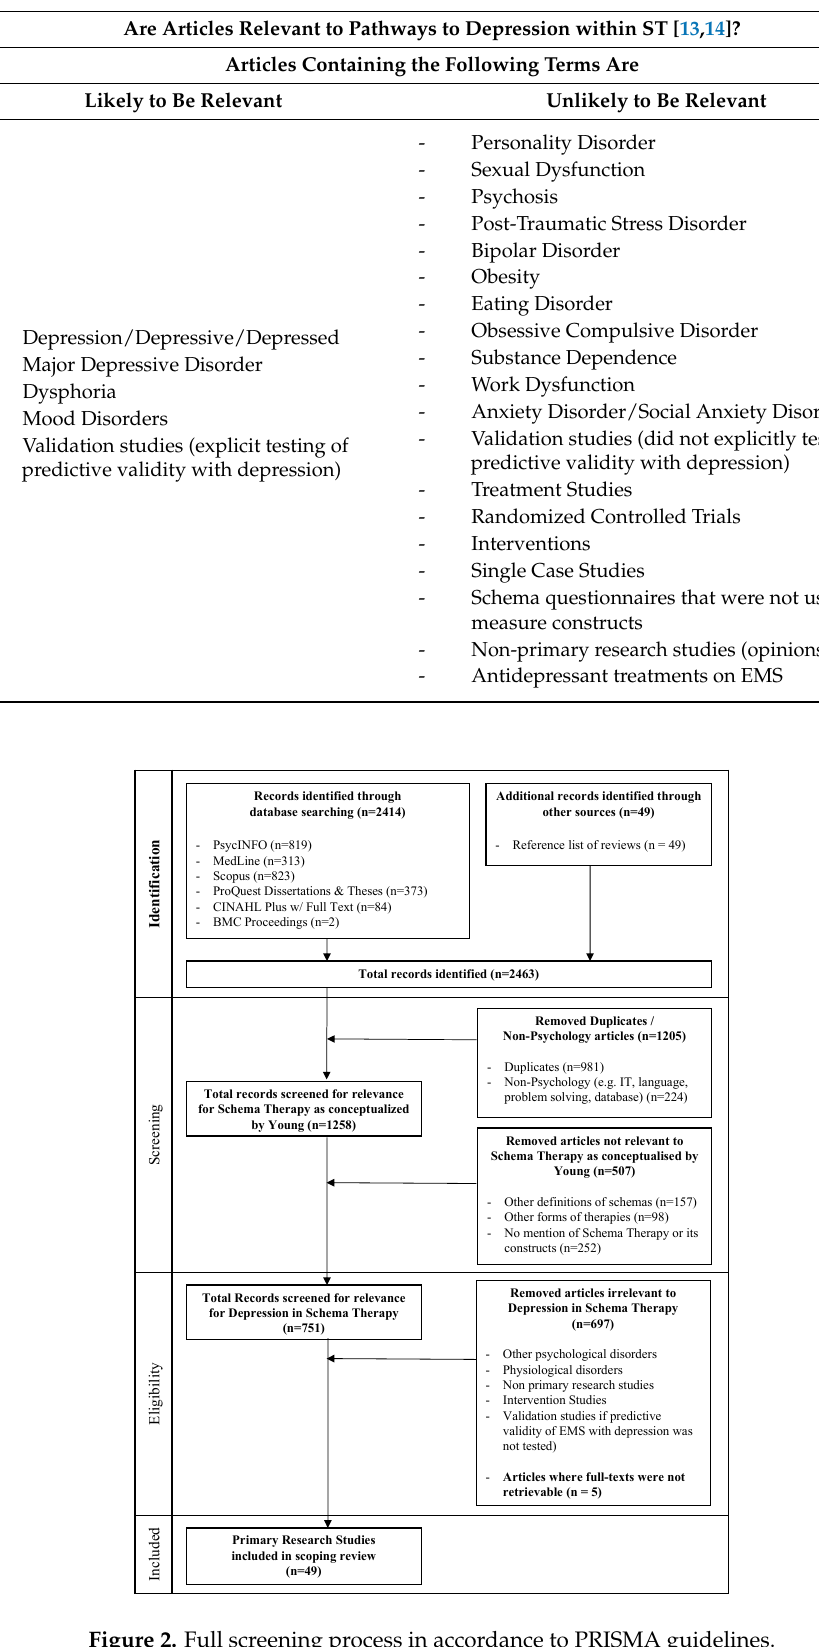
Table 2. Checklist to guide final stage screening for scoping review.